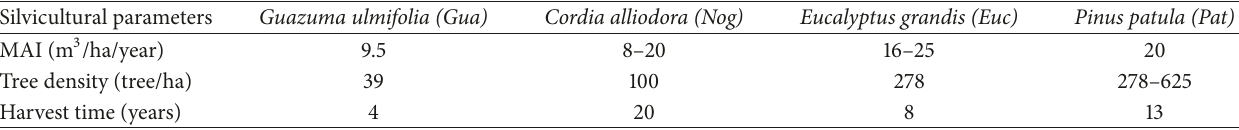
Table 3: Silvicultural parameters of firewood species selected.